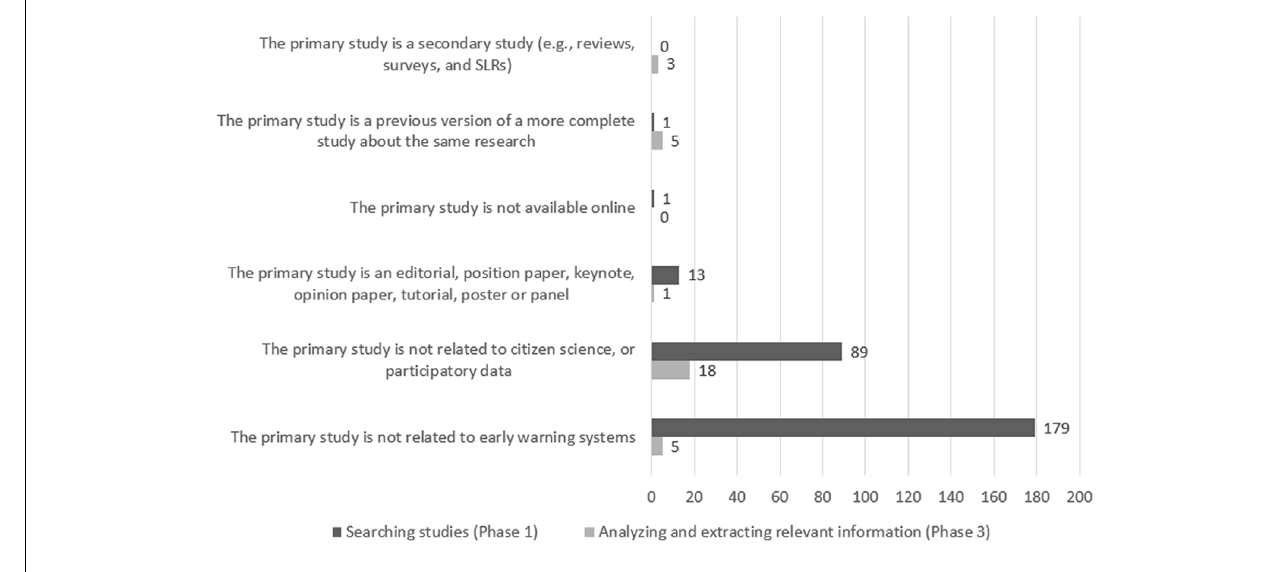
FIGURE 8 | Number of excluded studies per criteria, per phase.